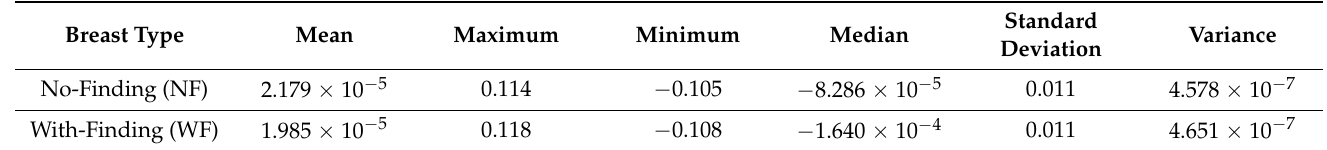
Table 3. Approximated quantitative summary of raw S 21 signals, as these values may vary with the addition of new